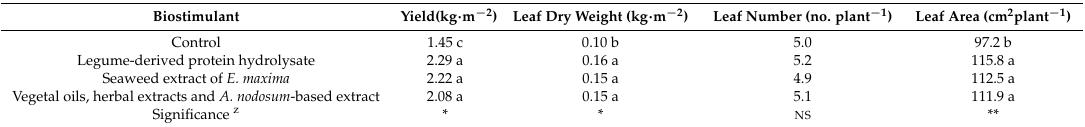
Table 1. The effect of biostimulant treatments on fresh yield, dry biomass, leaf number and total area of greenhouse spinach